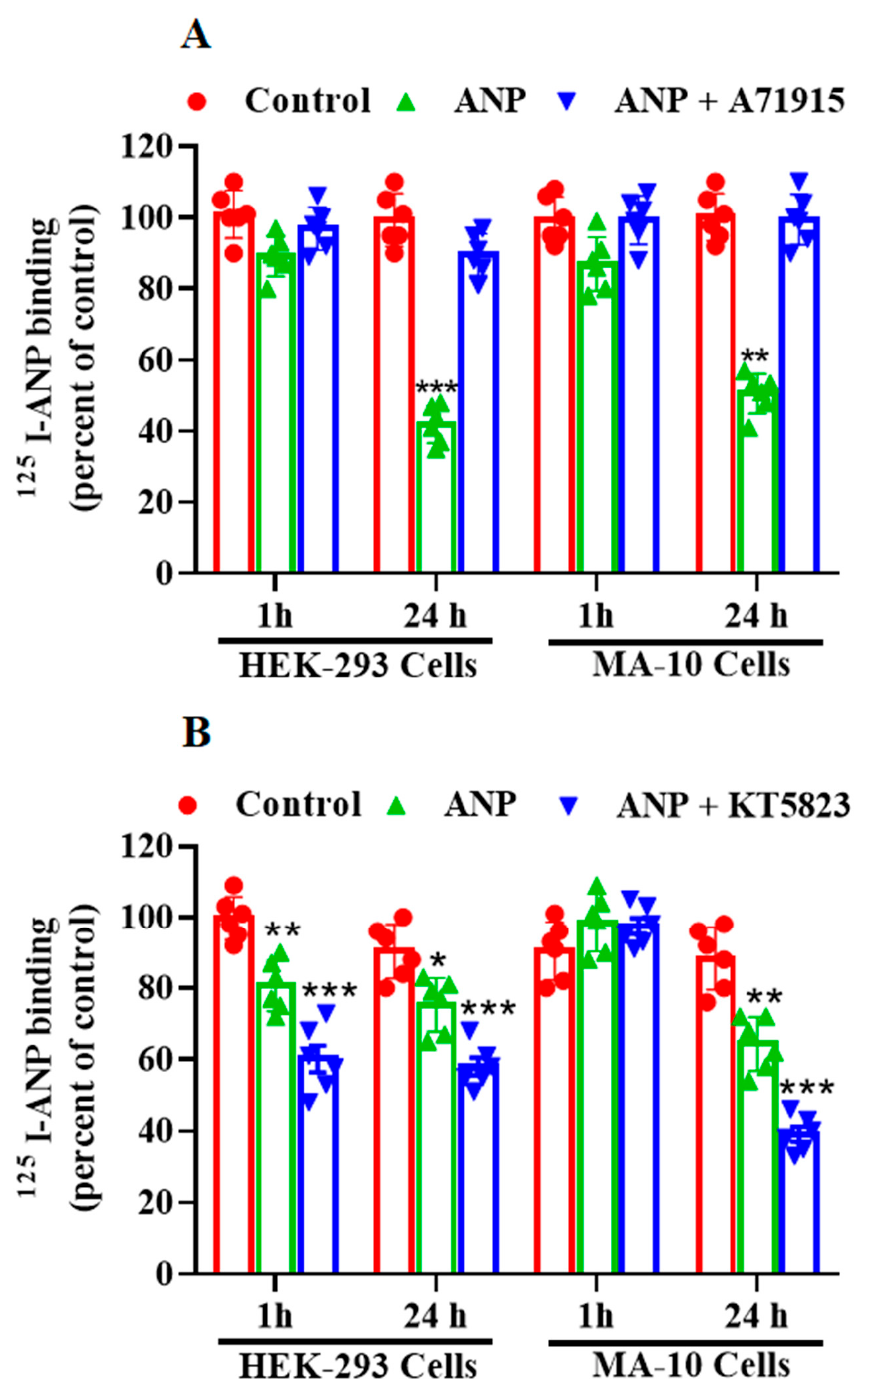
Figure 4. Effects of A71915 and KT 5823 pretreatment on 125 I-ANP binding to NPRA in HEK-293 and MA-10 cells. Confluent HEK-293 cells and MA-10 cells were pretreated with 100 nM ANP for the indicated times at 37 ◦ C after which cells were transferred to 4 ◦ C. Receptor binding was carried out as indicated under the Section 4. ( A ) Effect of NPRA antagonist, A71915 and ( B ) effect of PKG inhibitor, KT-5823 on 125 I-ANP binding in HEK-293 and MA-10 cells. The bars represent the mean ± SE of 6 determinations. * p < 0.05, ** p < 0.01, *** p < 0.001 (untreated vs. drug-treated group).